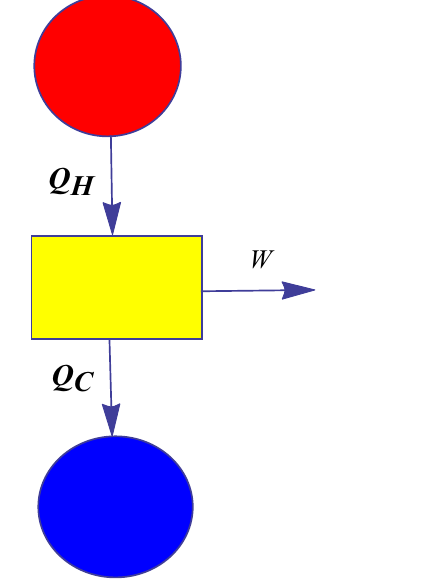
Fig. 1 The heat engine flows